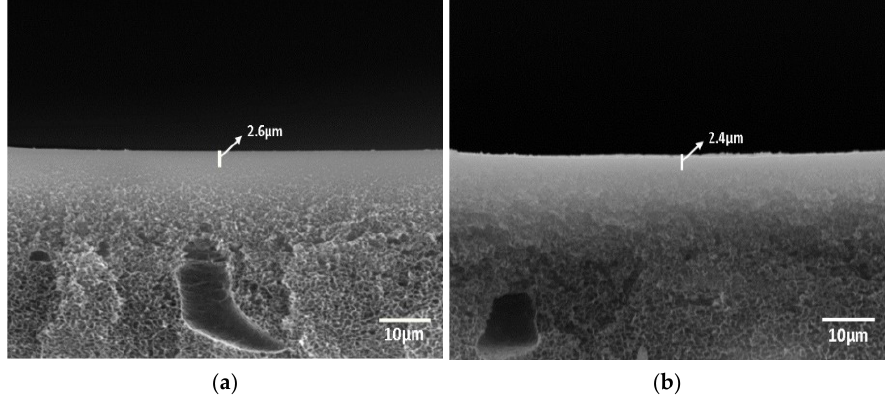
Figure 1. SEM images of ( a ) PEBAX-5513/AgNPs/TCNQ and ( b ) PEBAX-1657/AgNPs/TCNQ membranes.